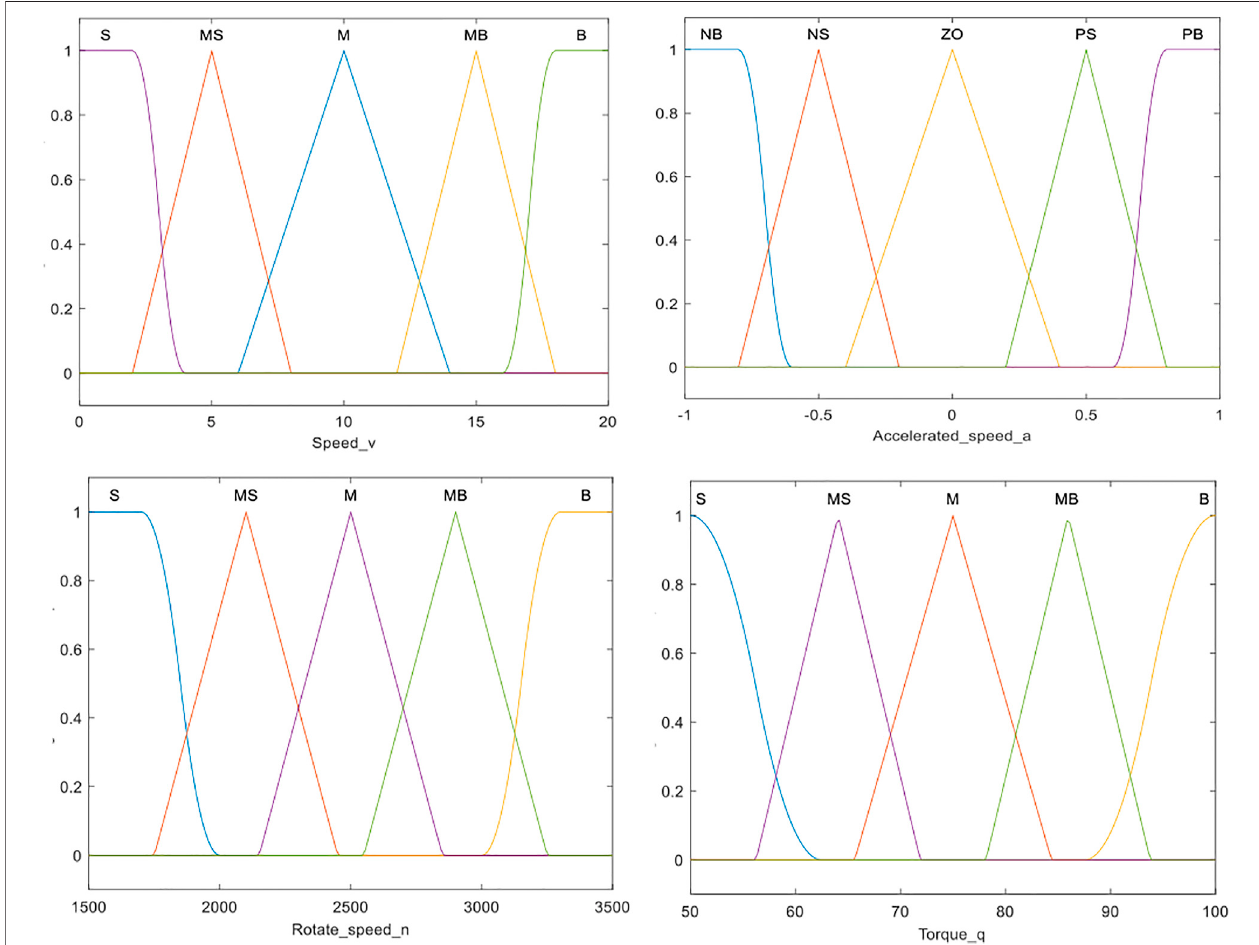
FIGURE 4 | Membership function of input and output